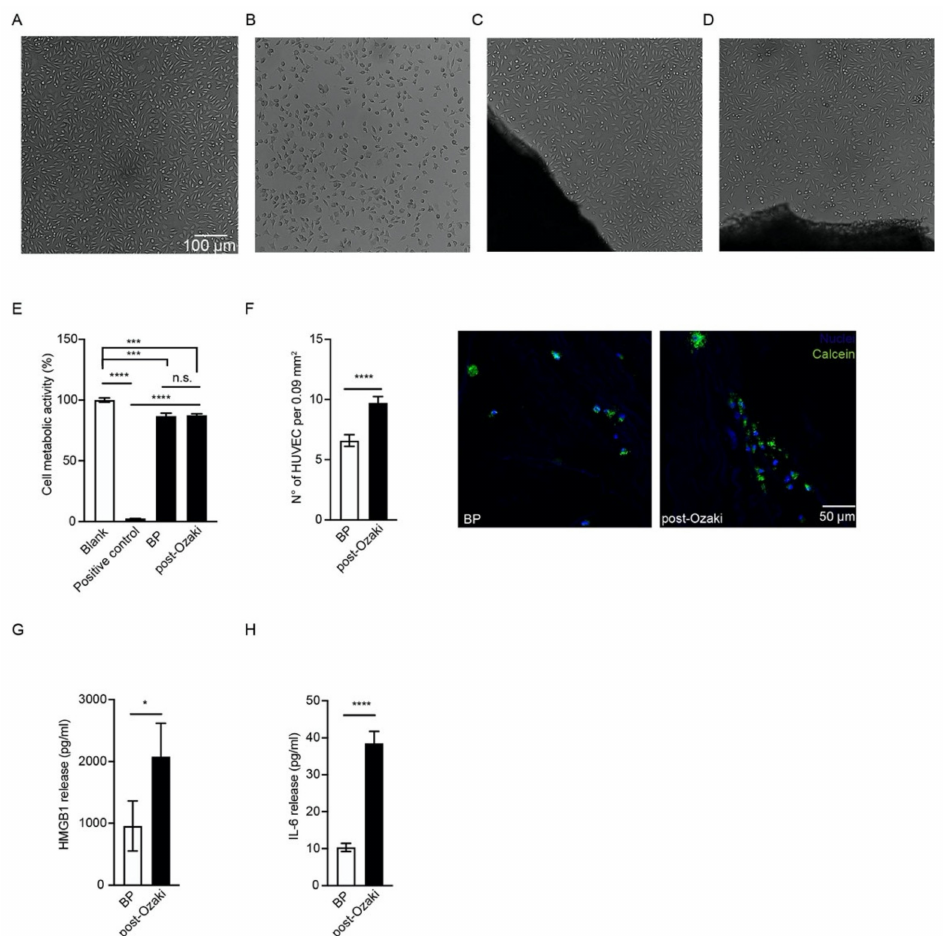
Figure 4. Citotoxicity assay, endothelialization, and expression of pro-inflammatory mediators in the post-Ozaki pericardium and BP control membranes. Morphology of L929 mouse fibroblasts cultured ( A ) without tested materials (blank), ( B ) in the presence of 0.6% GA (positive control), or grown in contact with ( C ) the commercial BP membrane (negative control) and ( D ) post-Ozaki samples. ( E ) Quantification of cytotoxicity by the MTT assay. Data are expressed as a percentage of viability referred to control cells growing without tested materials. *** p < 0.001, **** p < 0.0001; n = 15. ( F ) Quantification of endothelial cell number on the fibrous side of pericardium 4 days after seeding. **** p < 0.0001; n = 15. Representative images of HUVEC, labelled with the vital dye calcein-AM (in green) and the nuclear dye Hoechst (in blue), adhering on the BP membrane (left) and on post-Ozaki pericardium (right). Quantification of ( G ) HMGB1 and ( H ) IL-6 from cell culture supernatant after 4 days from seeding. * p < 0.05, **** p < 0.0001; n =